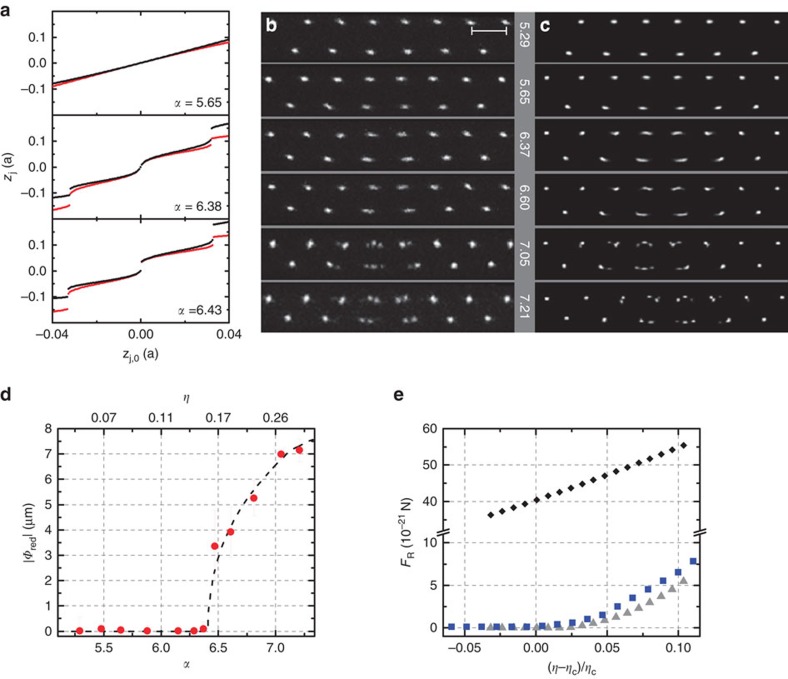
Symmetry breaking of the crystal and restoring force.(a) Numerically calculated hull functions in units of the lattice constant a for the two central ions, left (red points) and right (black points) to the crystal centre. Below αc=6.41 the hull functions are continuous. After the pinning transition is crossed they exhibit a central gap. Slightly below αc secondary gaps are observed. The inhomogeneity of the crystal leads to a lower charge density, and thus lower ωnatural, further away from the crystal centre. If the defect is not at the centre, the pinning transition occurs for α<αc. The secondary gaps of the central ions are the response to the analyticity breaking of the outer ions' hull functions. (b) Photos of experimentally observed 30-ion crystal configurations at different aspect ratios  from 5.29 to 7.21, as indicated in the grey bar. Relative errors are less than 1%. The exposure time is 700 ms. Laser 1 continuously cools the ions. No force is applied. The blurring of the ion positions near the sliding transition and the appearance of multiple configurations above it are due to thermal excitations. The scale bar is 16.5 μm. (c) Numerically simulated 30-ion crystal configurations at T=1 mK integrated over 10 ms of time evolution. (d) The absolute value of the order parameter |Φred| for 30 ions plotted against α and η. Experimental data (red circles) are shown in comparison to numerically obtained values for T=0 K (black dashed line). Experimental values represent a weighted average over 5–26 measurements, with exception of α=7.21, where only 2 configurations were observed. Error bars are one standard deviation weighted by fit errors. (e) Numerically calculated restoring force FR plotted against  for an inhomogeneous crystal (blue squares), a homogeneous crystal (grey triangles) and an ideal zigzag without defect (black diamonds). η refers to the inhomogeneous case. The parameters for the homogeneous and commensurate crystals were chosen to have an identical ratio of inner inter-ion distances a,b. The friction force needed in the ideal crystal slightly above the pinning transition is roughly an order of magnitude bigger.